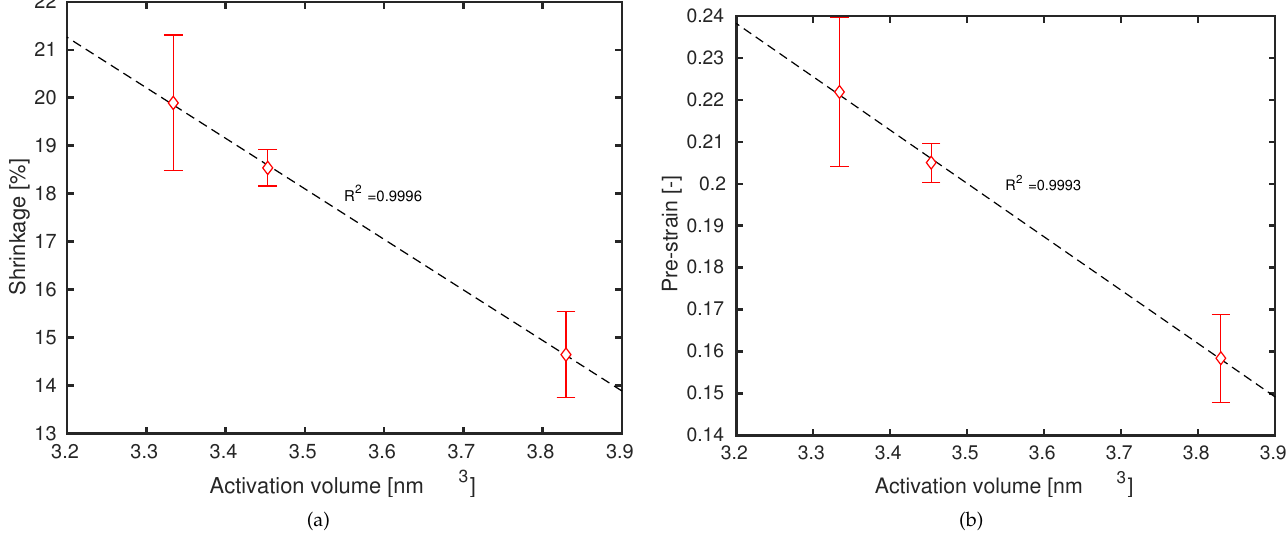
Figure 6. ( a ) dimensional length changes as a function of determined activation volume; ( b ) estimated pre-strain as a function of determined activation volume. Symbols are experimental results. Lines are a guide to the